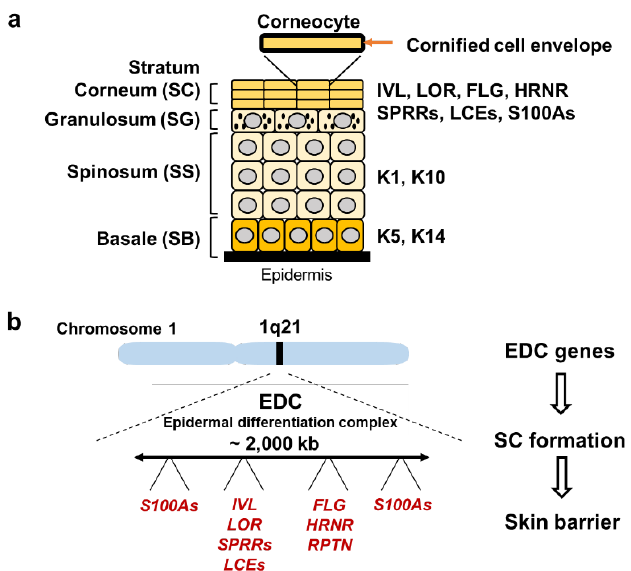
Figure 3. Structure of the epidermis and genes regulated by AHR and NRF2. ( a ) Structure of the epidermis. The epidermis includes four layers: SC, SG, SS and SB. Through cell migration from SB toward SC, keratinocytes start differentiation and sequentially express specific proteins, such as Keratin 5/14 at the SB stage and Keratin 1/10 at the SS stage. The outer layer SC consists of corneocytes, which are surrounded by a cornified cell envelope. SC expresses IVL, LOR, FLG, SPRRs, LCEs and the S100A family. ( b ) EDC on human chromosome 1q21. EDC genes encode the components of SC and function in the formation of the skin barrier.